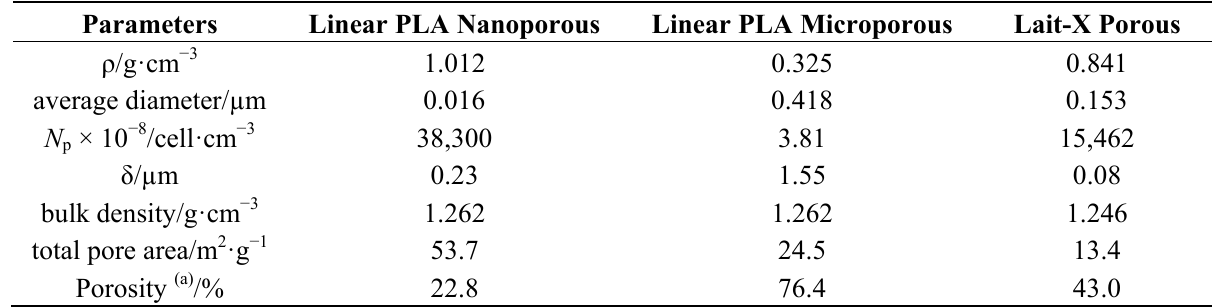
Table 1. Morphological properties of linear and crosslinked polylactide (PLA) porous structures.